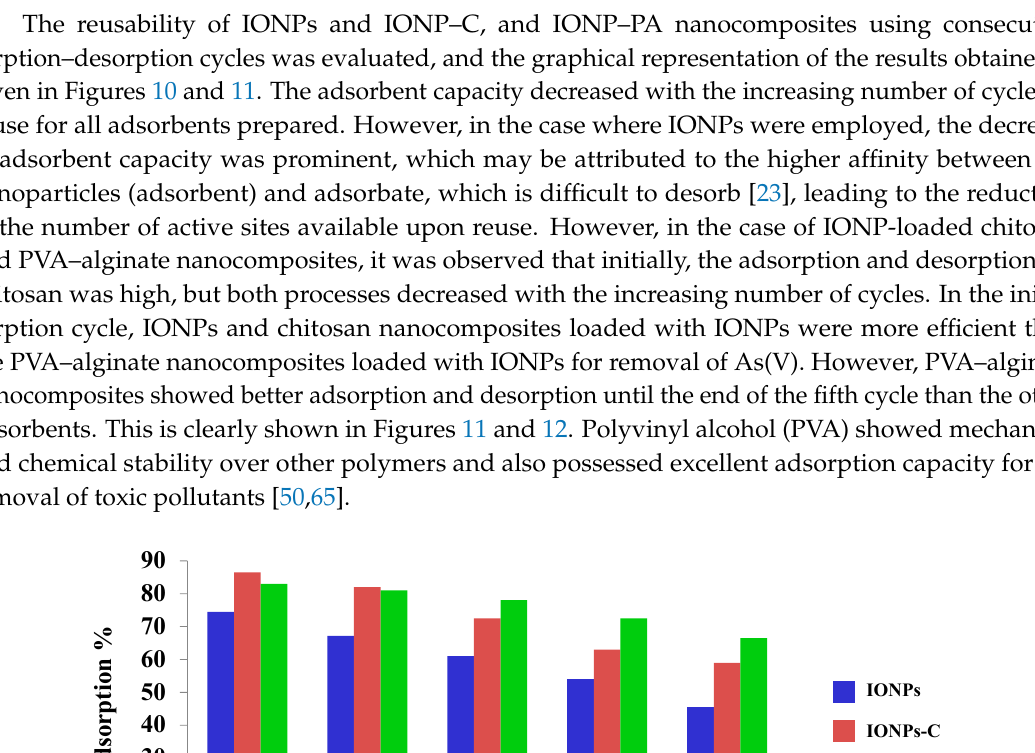
Table 3. Adsorption capacity of different adsorbents for As(V) removal.